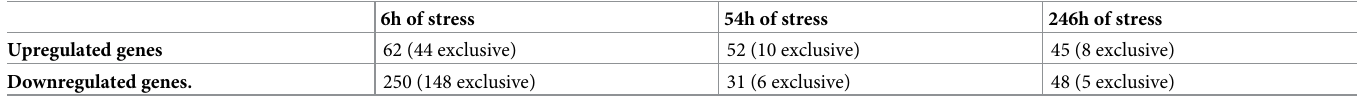
Table 1. General description of the